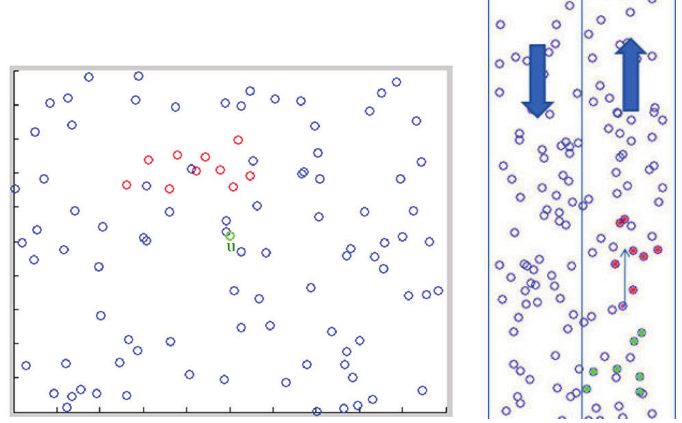
Figure 5. The proposed HDTC scheme ( Left ); the vehicle and its group members ( Right